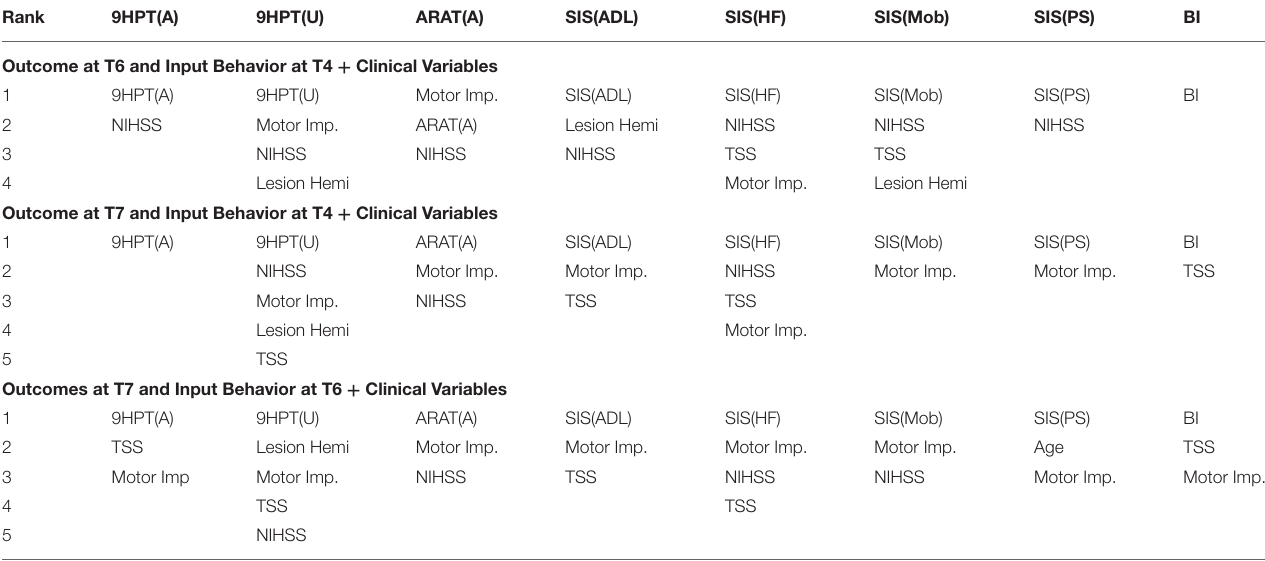
TABLE 9 | List of behavioral and clinical correlates at preceding time-points using linear-kernel SVR for estimation of measures at succeeding time-points are presented below.